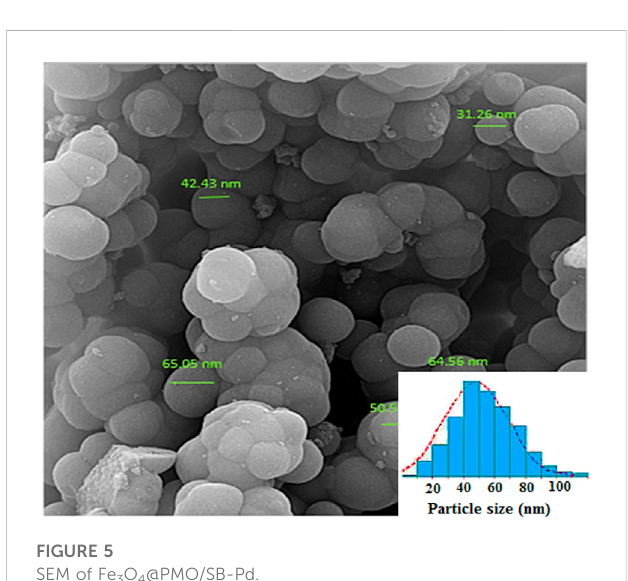
FIGURE 5 SEM of Fe 3 O 4 @PMO/SB-Pd.